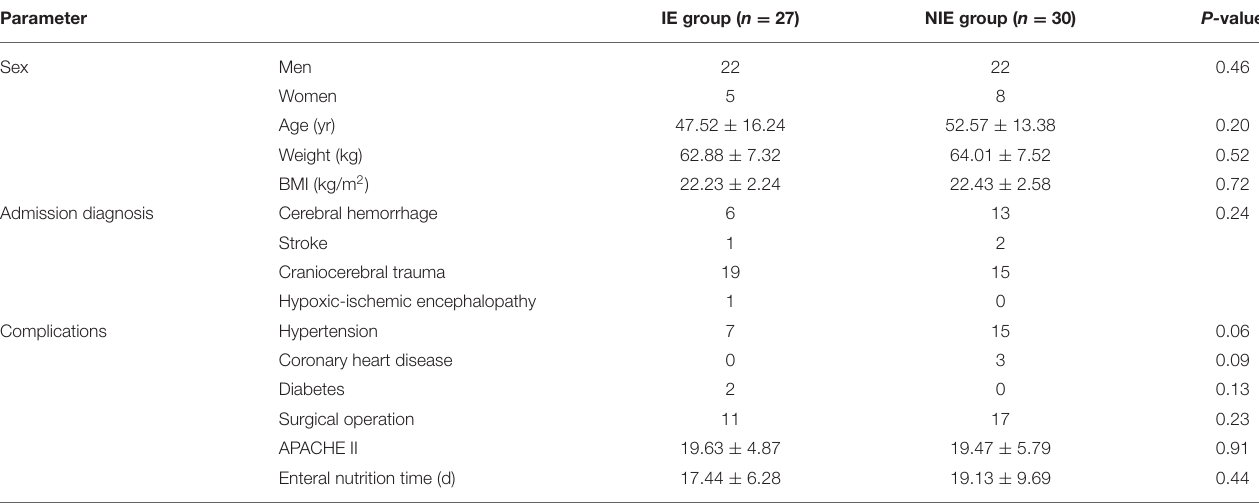
TABLE 1 | Demographic data and parameters on admission. Parameter